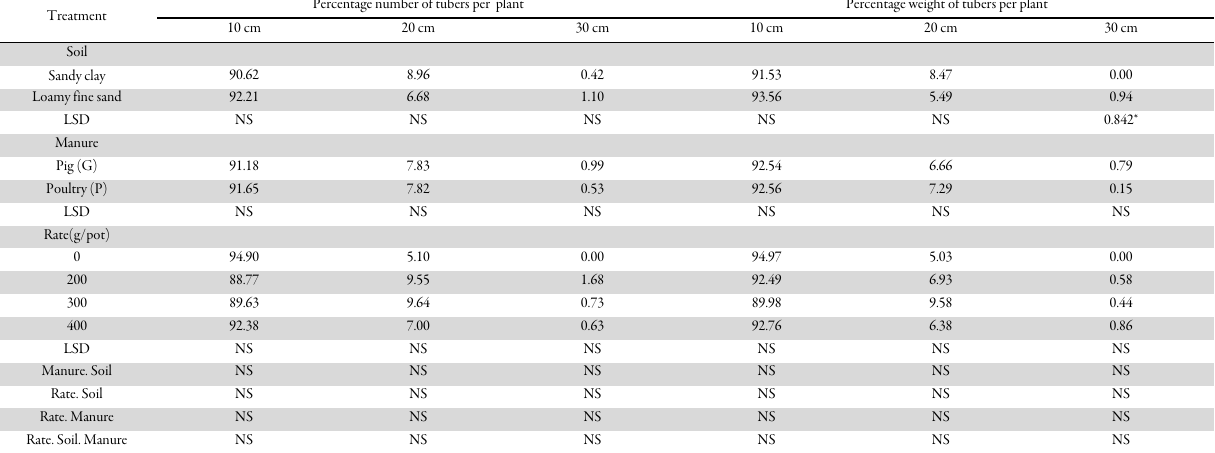
Table 12. Percentage and weight of tiger nut tubers per plant at different depth as affected by soil texture and rates of poultry or pig manure. Values are a mean of 5 plants